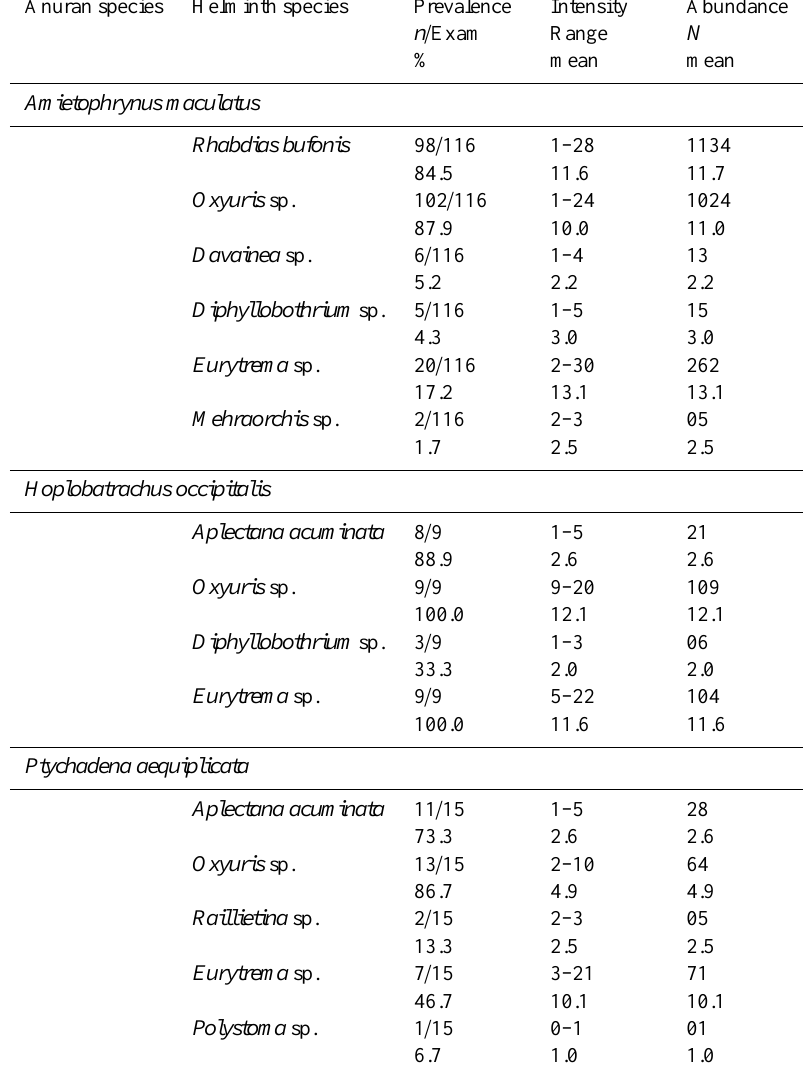
Table 3. Infection parameters of the helminthes parasitizing three anuran species from Port Harcourt, Nigeria. Symbols: n = number of infected hosts. Exam = number of examined hosts. N = overall number of helminthes. Anuran species Helminth